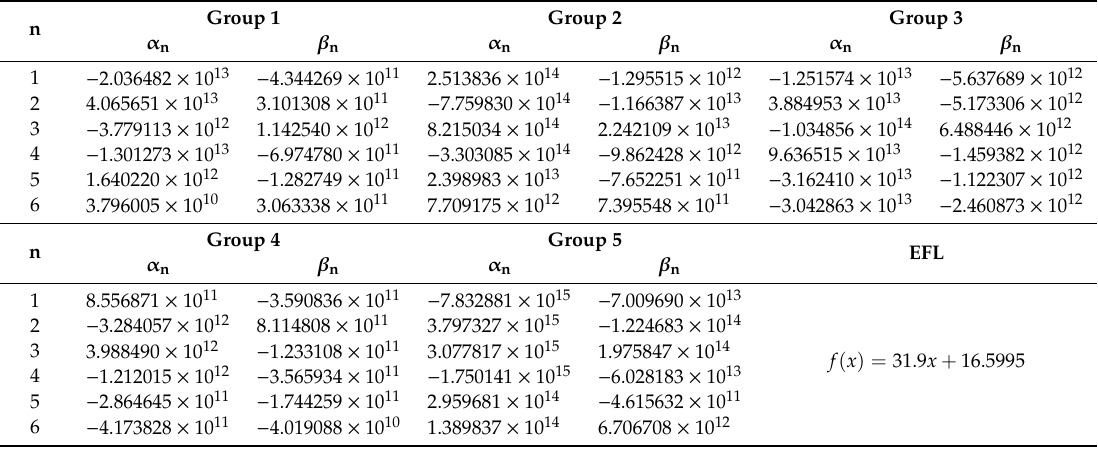
Table 8. Coe ffi cients of the rational function for each lens group calculated by the Pad é approximation, shown in Table 5.